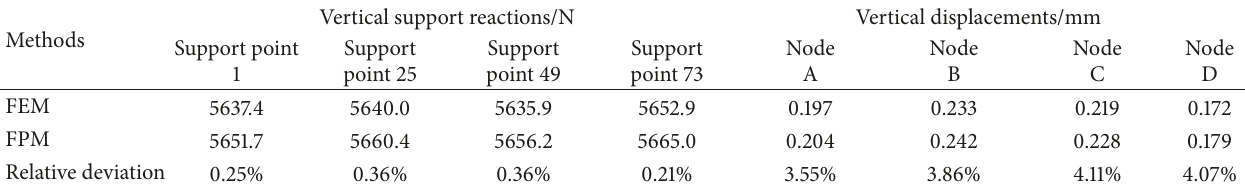
Table 4: Support reactions and vertical displacements of nodes under gravity